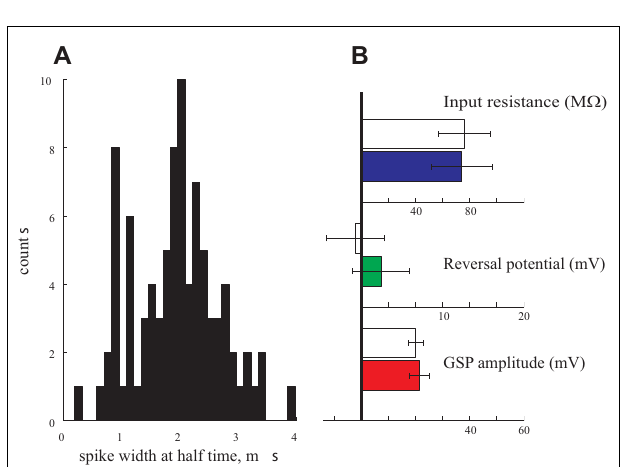
FIGURE 7 | Pyramidal neurons vs. interneurons. (A) The spike duration at half width of 95 cells is bimodal pointing to a pyramidal population (with an average of 2 ms duration) and an interneuronal population (with an average of 1 ms duration). (B) Amplitude (red), reversal potential (green), and R in (blue) of the two populations. Filled bars represent the pyramidal population and empty bars represent the interneuronal population.